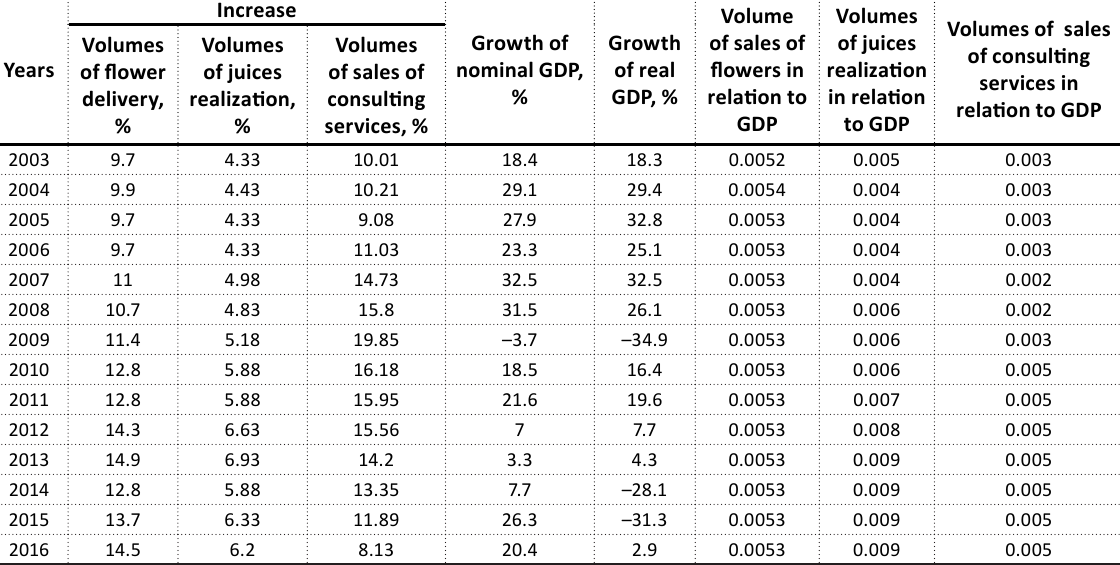
Table 1. Dynamics of sales